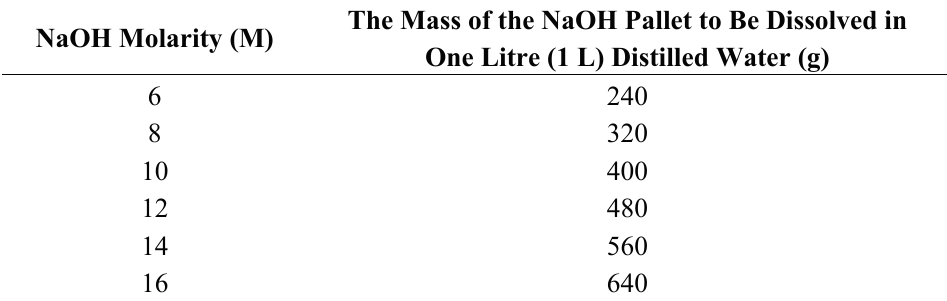
Table 2. Detail preparation of NaOH solution.